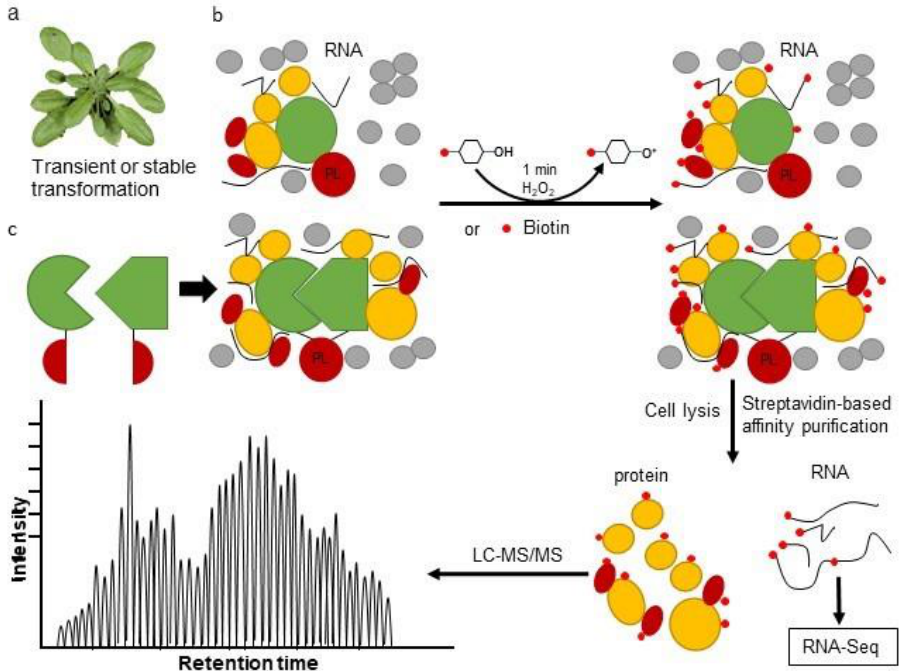
Figure 2. Overview of proximity labeling system. ( a ) Transient and stable protein with proximity- labeling (PL) enzyme transformation. ( b ) PL assay based on the tagged PL enzyme. A biotin ligase or APEX PL enzyme is fused to the target protein and expressed in plants. Upon the addition of a substrate, such as biotin or biotin-phenol and hydrogen peroxide (H 2 O 2 ), proteins or RNAs are tagged by biotin. ( c ) Interacting pairs are fused to the PL enzyme at either the N- and C-terminus to investigate the composition of protein complexes. As two proteins interact in cells, the two halves of a split-PL are reorganized as a full PL enzyme and initiate the labeling of proximal part- ners of the protein complex. After protein extraction and incubating with streptavidin beads, bio- tin-labeled proteins or RNAs can be enriched for subsequent LC-MS/MS or high-throughput se- quencing analysis.